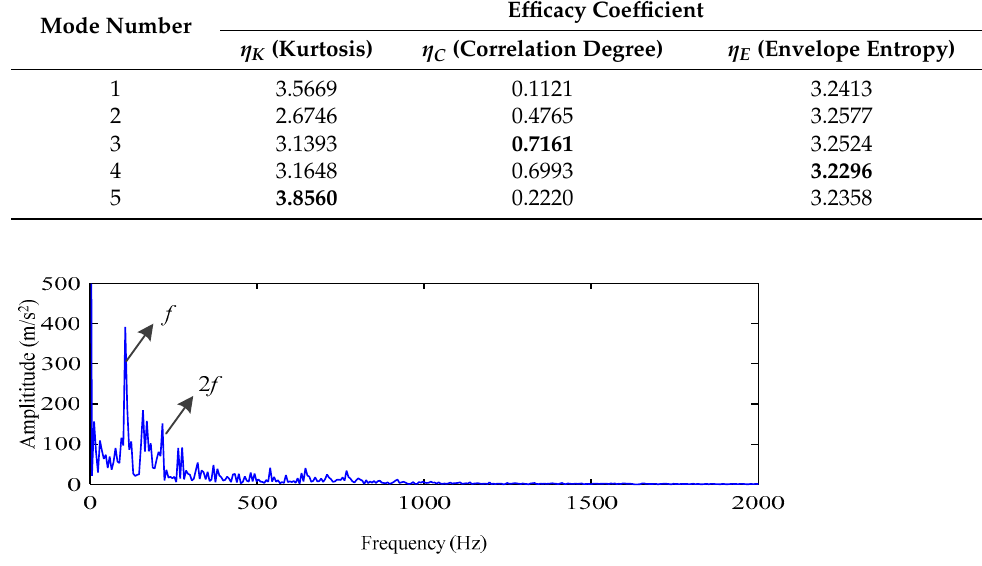
Figure 27. The envelope spectrum of the optimal component by using IVMD.